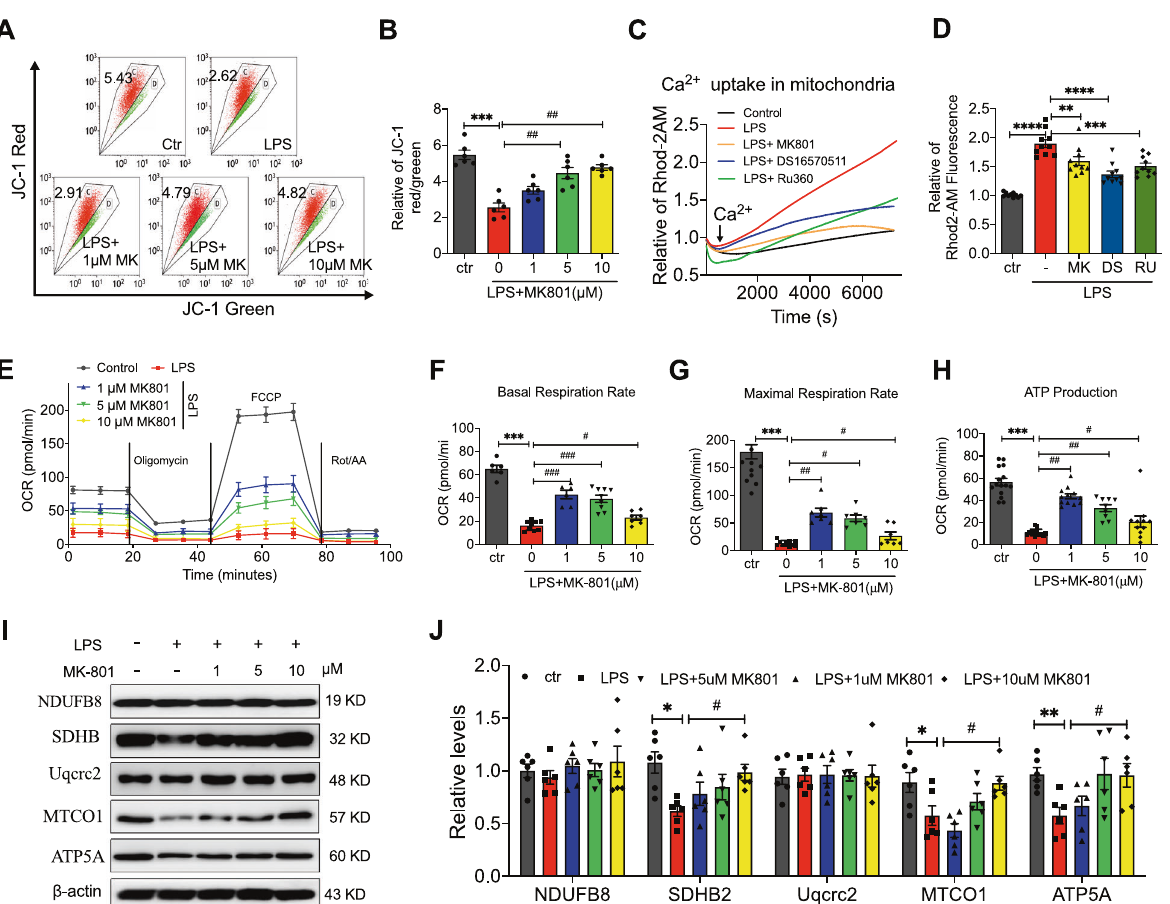
Fig. 2 Protective effects of MK801 against LPS-induced mitochondrial dysfunction in HUVECs. A Flow cytometry graphs and B analysis of mitochondrial transmembrane potential in HUVECs treated with LPS in the absence or presence of indicated doses of MK801. Representative of traces ( C ) and quanti fi cation at 10 min ( D ) of mitochondria Ca 2 + in fl ux labeled with Rhod-2 AM in HUVECs treated with LPS in the presence or absence of Ru360 (mitochondrial calcium uptake inhibitor), DS16570511 (MCU inhibitor), or MK801 for 2 h. E – H O 2 consumption rates ( D ), basal ( E ) and maximal respiration rate ( F ), and ATP production ( G ) in HUVECs treated with LPS in the presence or absence of MK801. Representative of western blotting images ( I ) and quanti fi cation ( J ) of NDUFB8, SDHB2, UQCRC2, MTCO1, and ATP5a in HUVECs treated with LPS in the presence or absence of MK-801 at indicated doses. (Data are presented as mean ± SEM, *** P < 0.001, ** P < 0.01, * P < 0.05 vs. Control; ### P < 0.001, ## P < 0.01, # P < 0.05 vs.